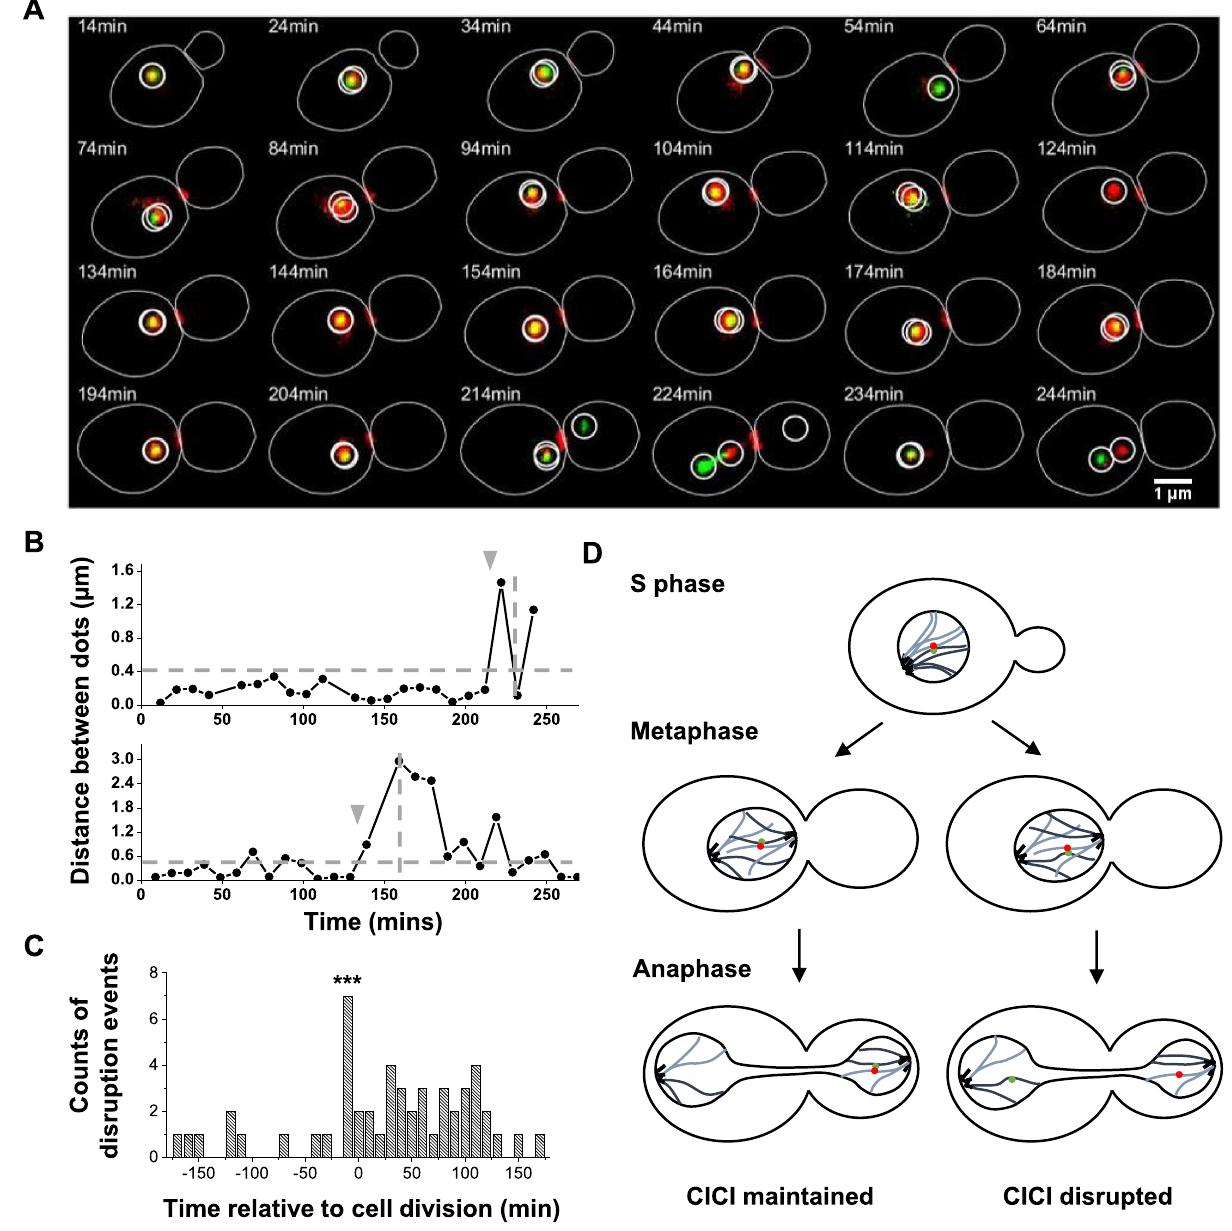
Fig. 4 CICI is disrupted shortly before cell division in a fraction of cells. A Example time-lapse images of CICI strain (pair 5) that show CICI disruption near the end of the cell cycle. B Distance between LacO and TetO arrays as a function of time in two cells. The upper panel is derived from the mother cell in ( A ). The horizontal line represents the co-localization threshold (0.4 µ m), and the vertical lines show the time of cell division. The gray arrows point to the time of CICI disruption. C Histogram of the time of CICI disruption relative to the end of the cell cycle (total CICI disruption events N = 36). The seven disruption events near the end of the cell cycle are statistically signi fi cant (one-sided Student ’ s t -test, P value < 0.001). D Model of CICI disruption during anaphase. For clarity, only one of the two CICI pairs is shown in these cells. Source data for B and C are provided as a Source Data fi